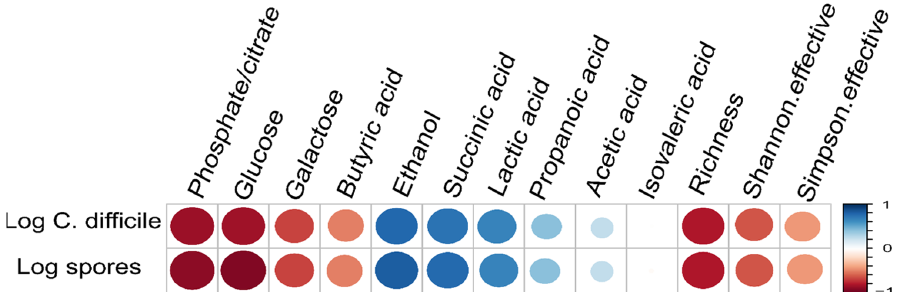
Figure 6. Heat map of pairwise correlation of C. difficile cell and spore counts (data from 5) with the metabolites phosphate/citrate, glucose, galactose, butyric acid, ethanol, succinate, lactic acid, propionic acid and isovaleric acid, and the alpha diversity indicators richness, Shannon effective index and Simpson effective index.